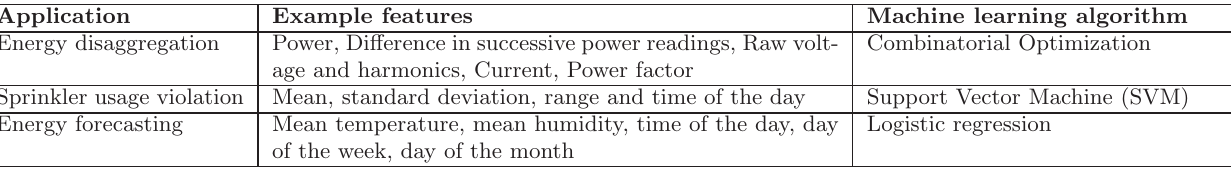
Table 1: Motivating energy management applications which require complex features and analytics on top of the collected sensor